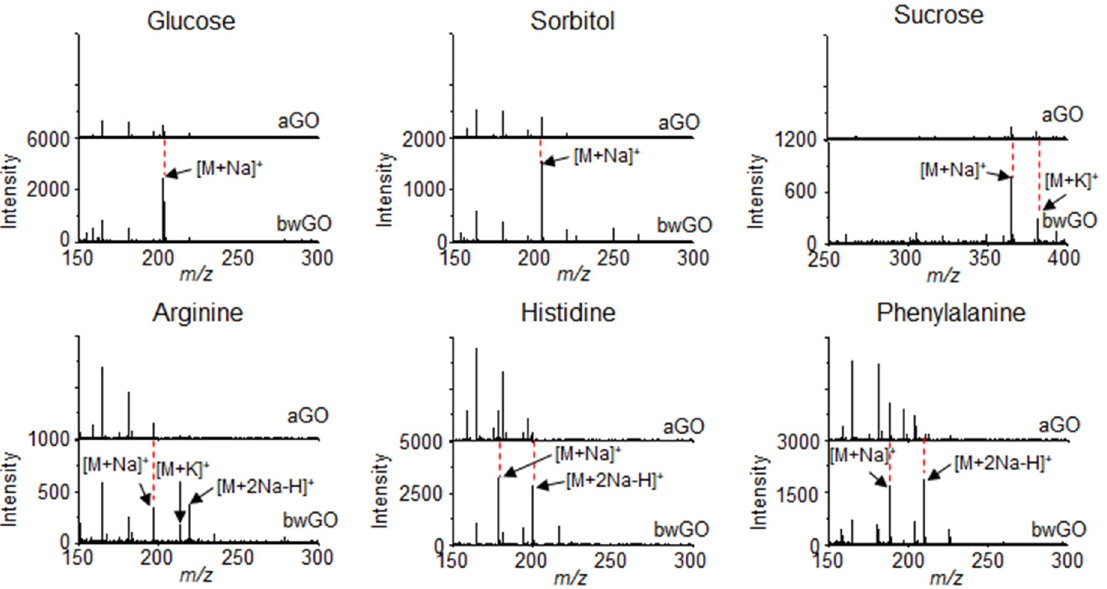
Figure 3. LDI-TOF-MS spectra of small molecules such as glucose, sorbitol, sucrose, arginine, histidine, and phenylalanine obtained with aGO and bwGO. Reproduced with permission from ref. [67]. Copyright (2019) Japan Society for Analytical Chemistry.